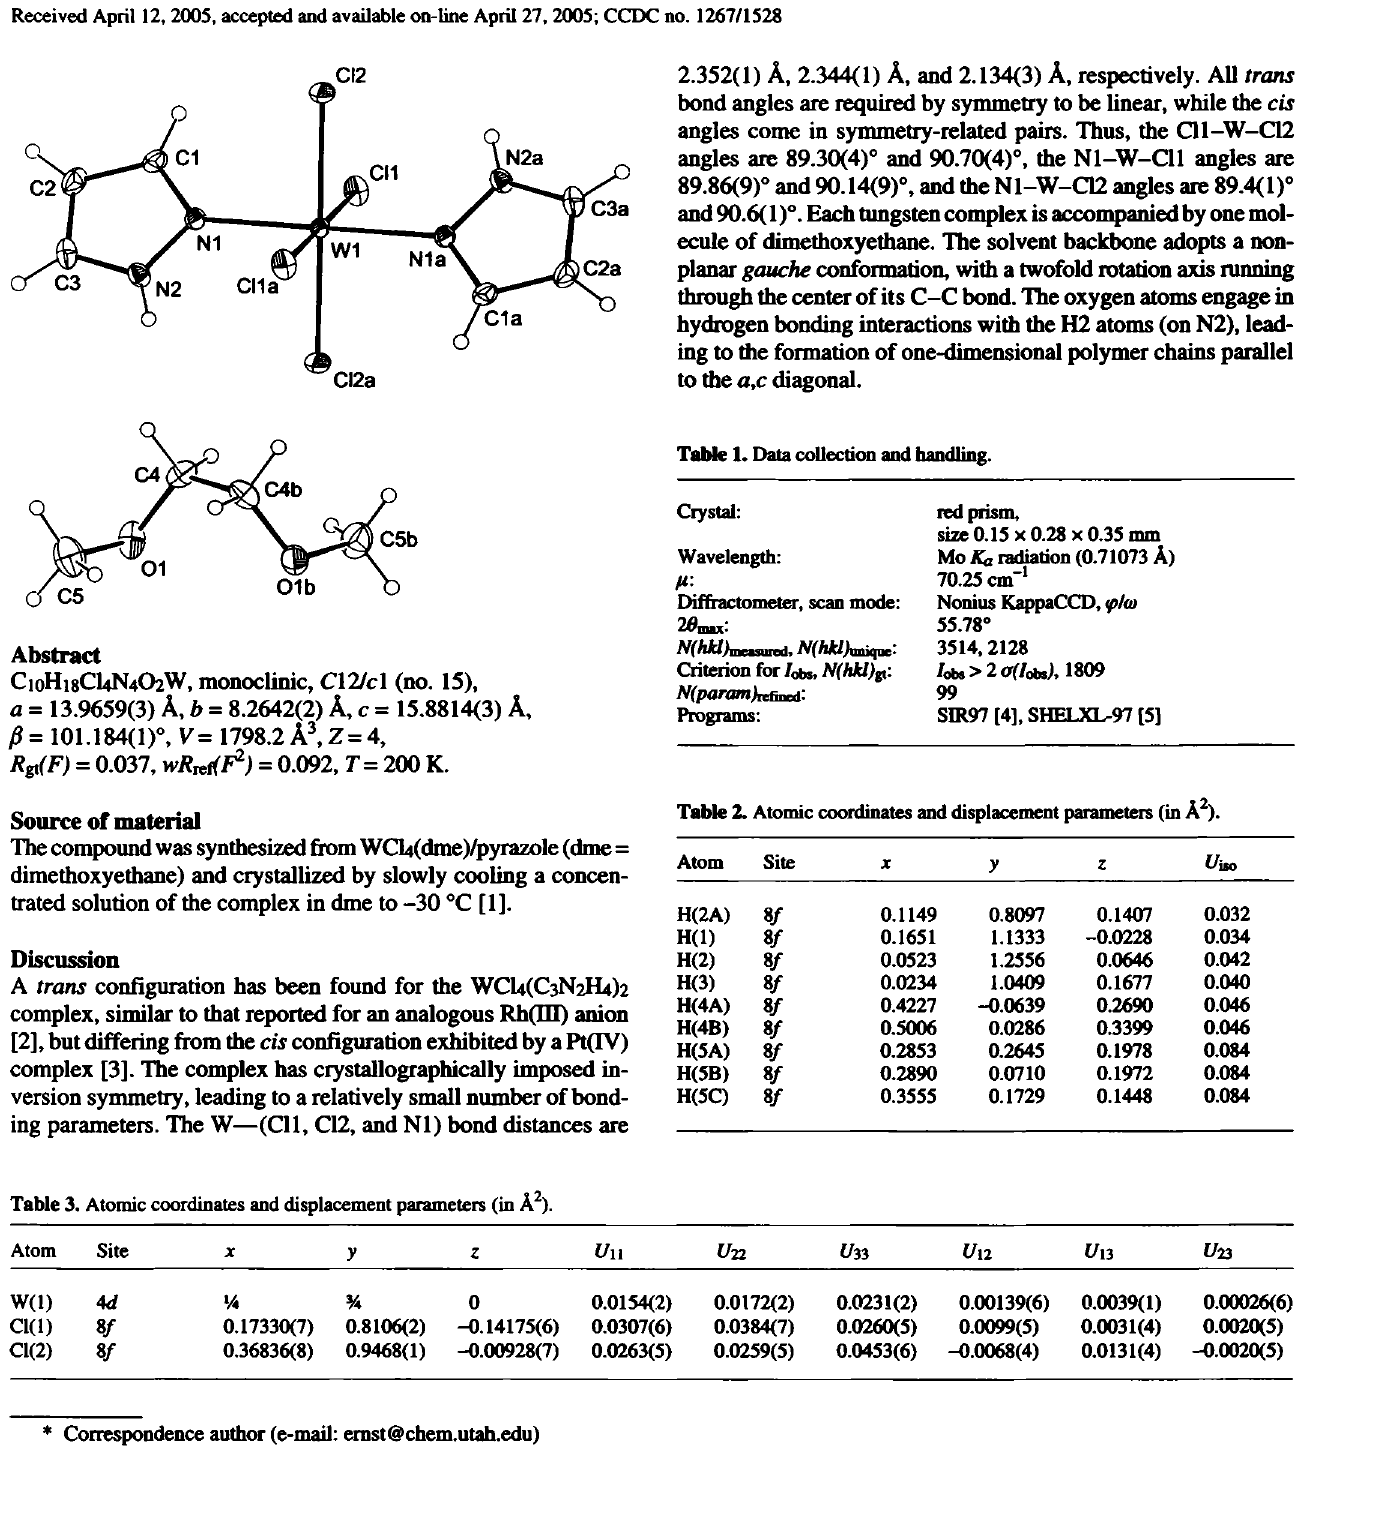
Table 3. Atomic coordinates and displacement parameters (in A 2